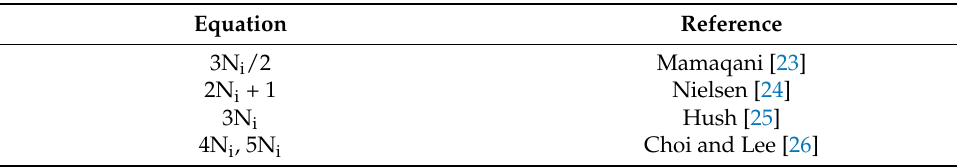
Table 3. Equations for determining the numbers of nodes.